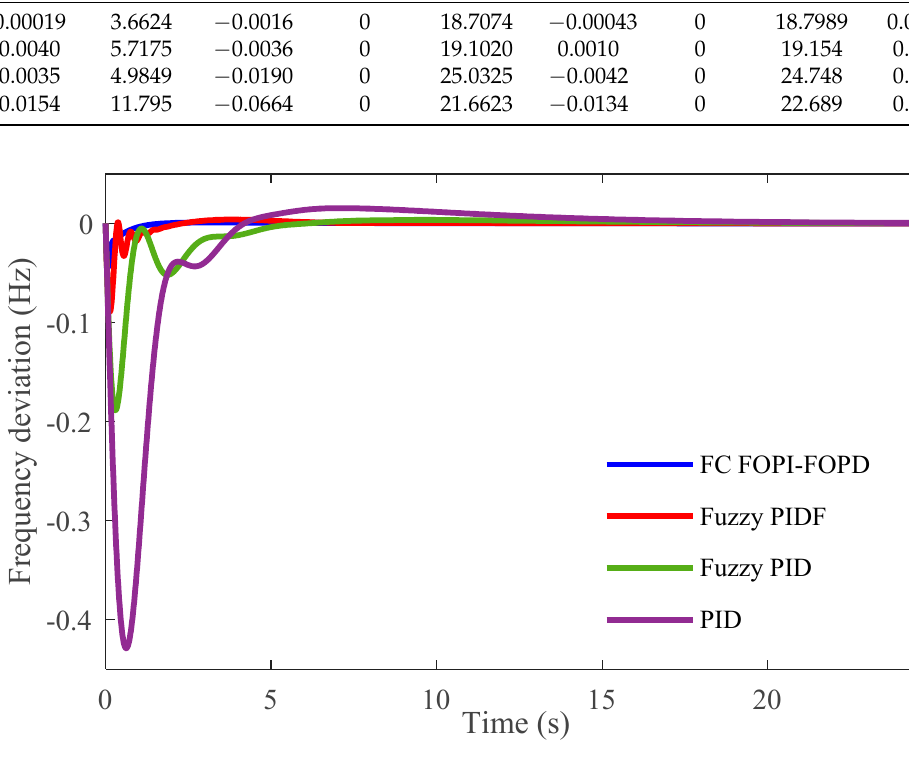
Figure 4. Frequency drop in area one.